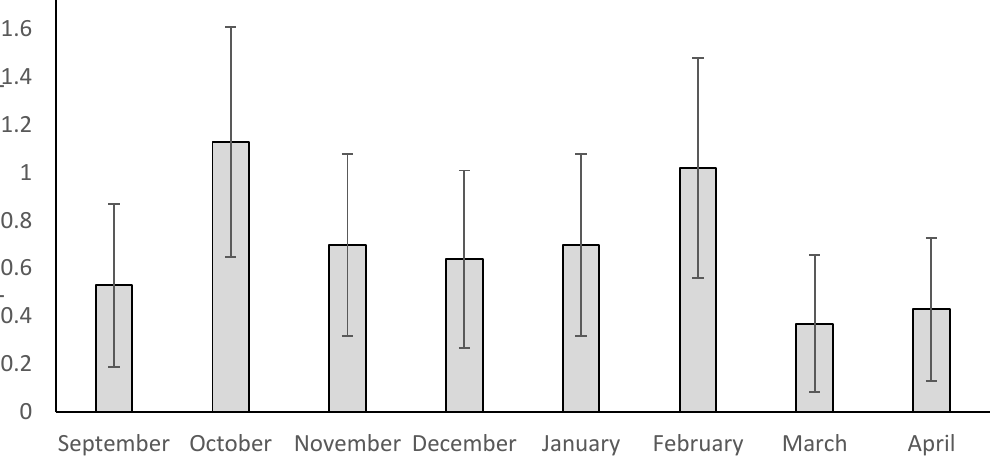
Table 5. Percentage of injuries, injury rate (IR, number of injuries per 1000h of exposure), 95% confidence intervals (CI) for contact and non ‐ contact injuries, and corresponding injury mechanisms.